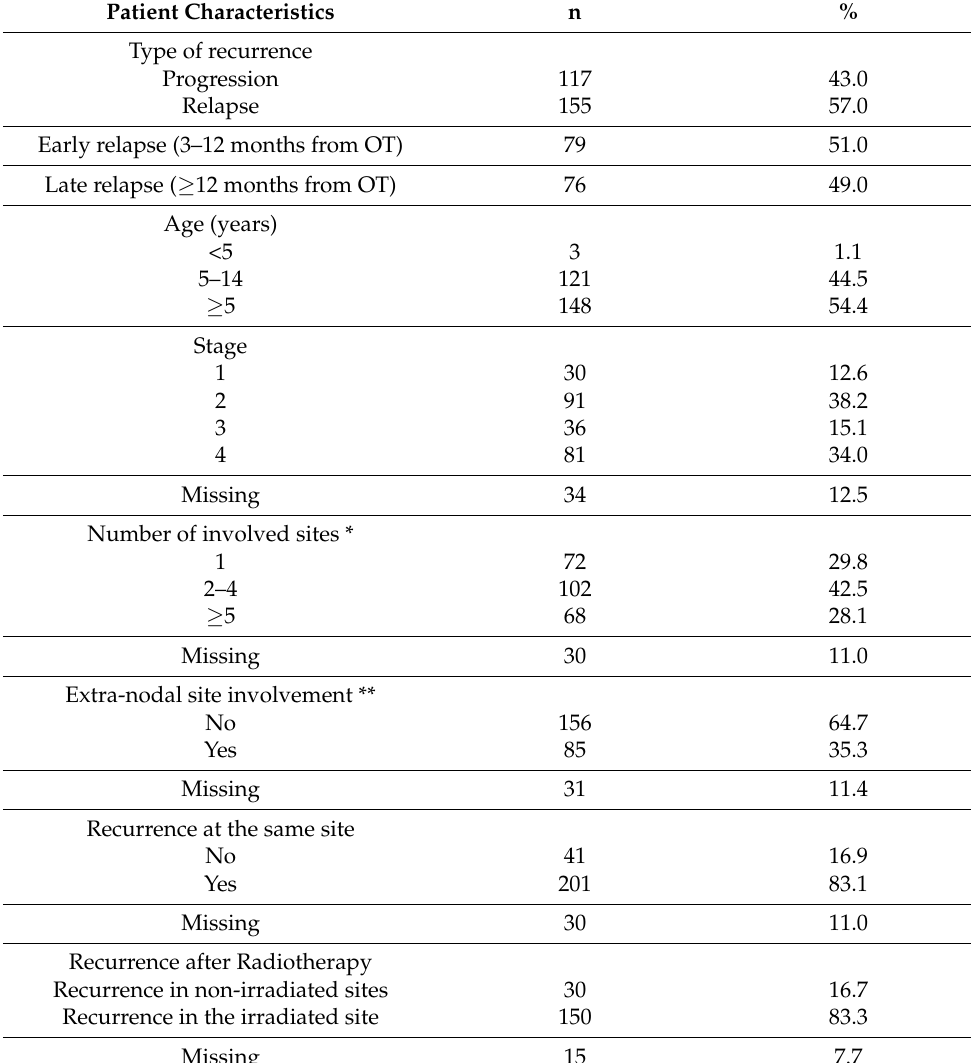
Table 4. Characteristics at disease recurrence of 272 patients with classical Hodgkin’s lymphoma. Patient